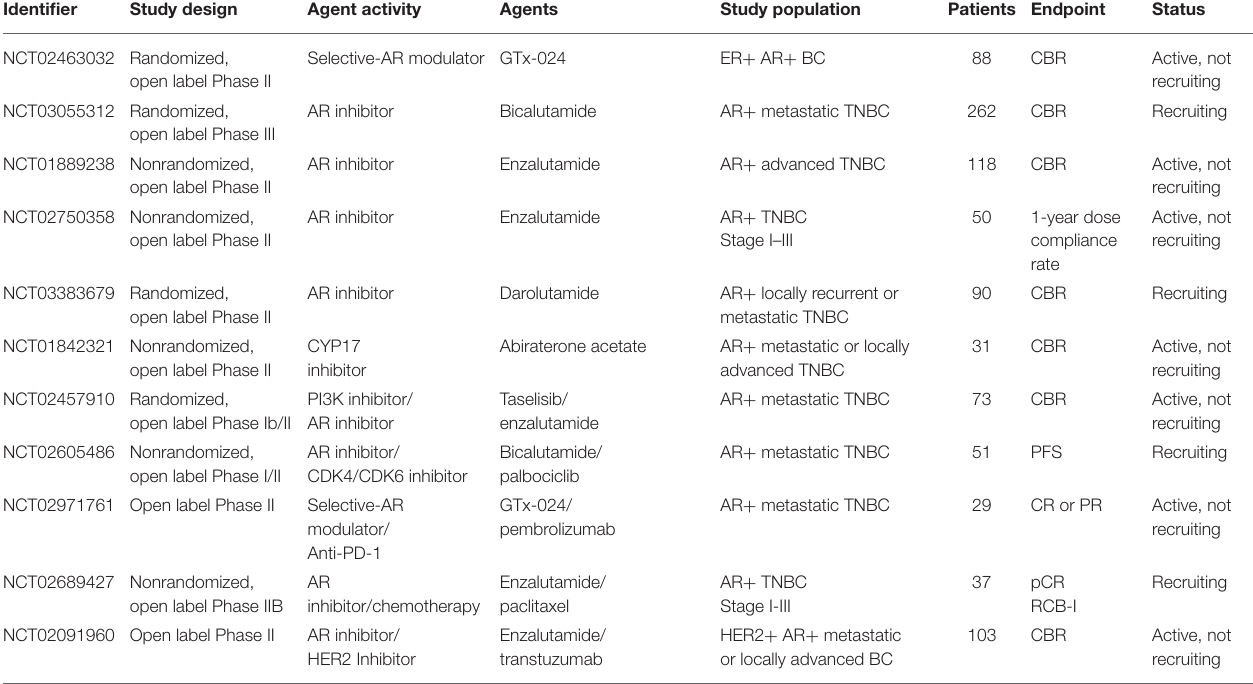
TABLE 2 | AR-targeted clinical trials in breast